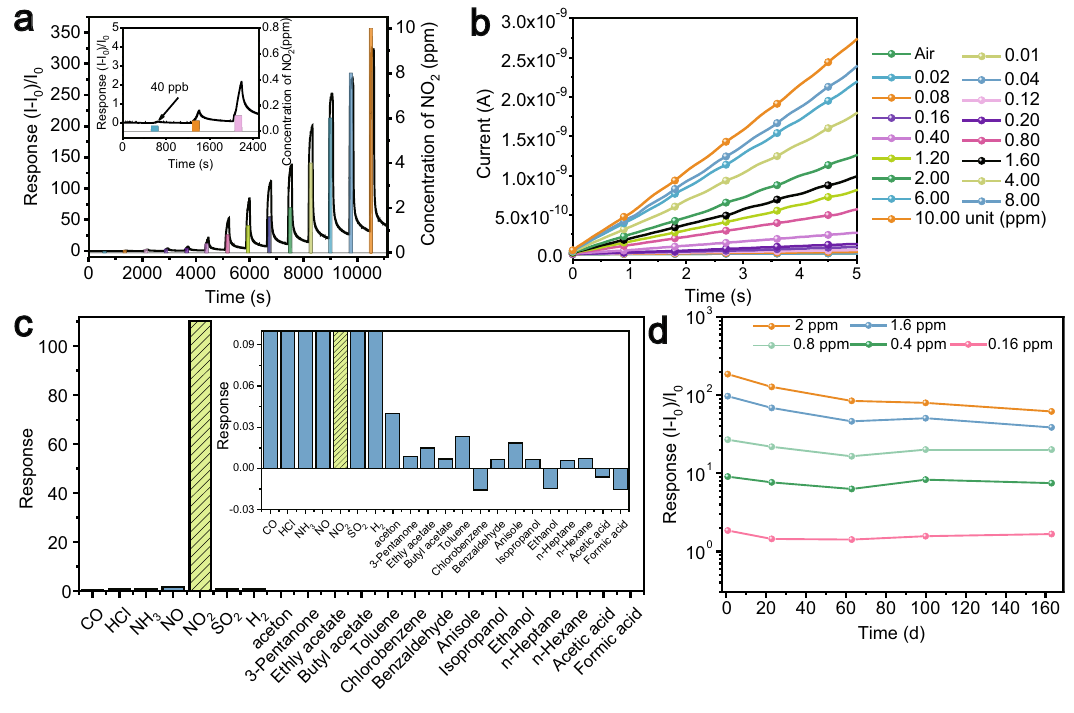
Fig. 2 | Characterization of sensing performance. a Responses variation versus NO 2 concentrations (40ppb to 10ppm). b Current – voltage characteristics for sensorwhenexposedtodifferentNO 2 concentrations(0 – 10ppm). c Gasselectivity